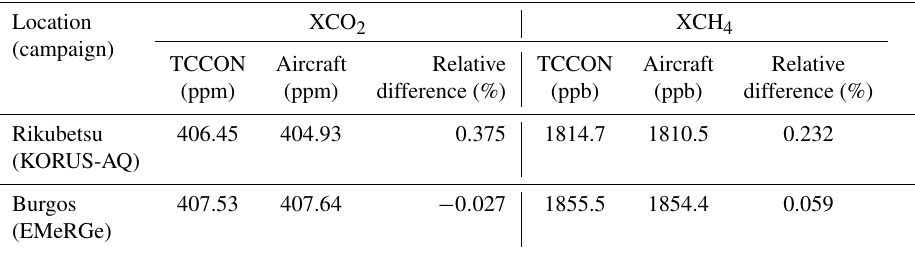
Table 5. Comparison of TCCON data with aircraft XCO 2 and XCH 4 data. The relative differences are calculated as follows: (TC- CON − aircraft)/aircraft ×